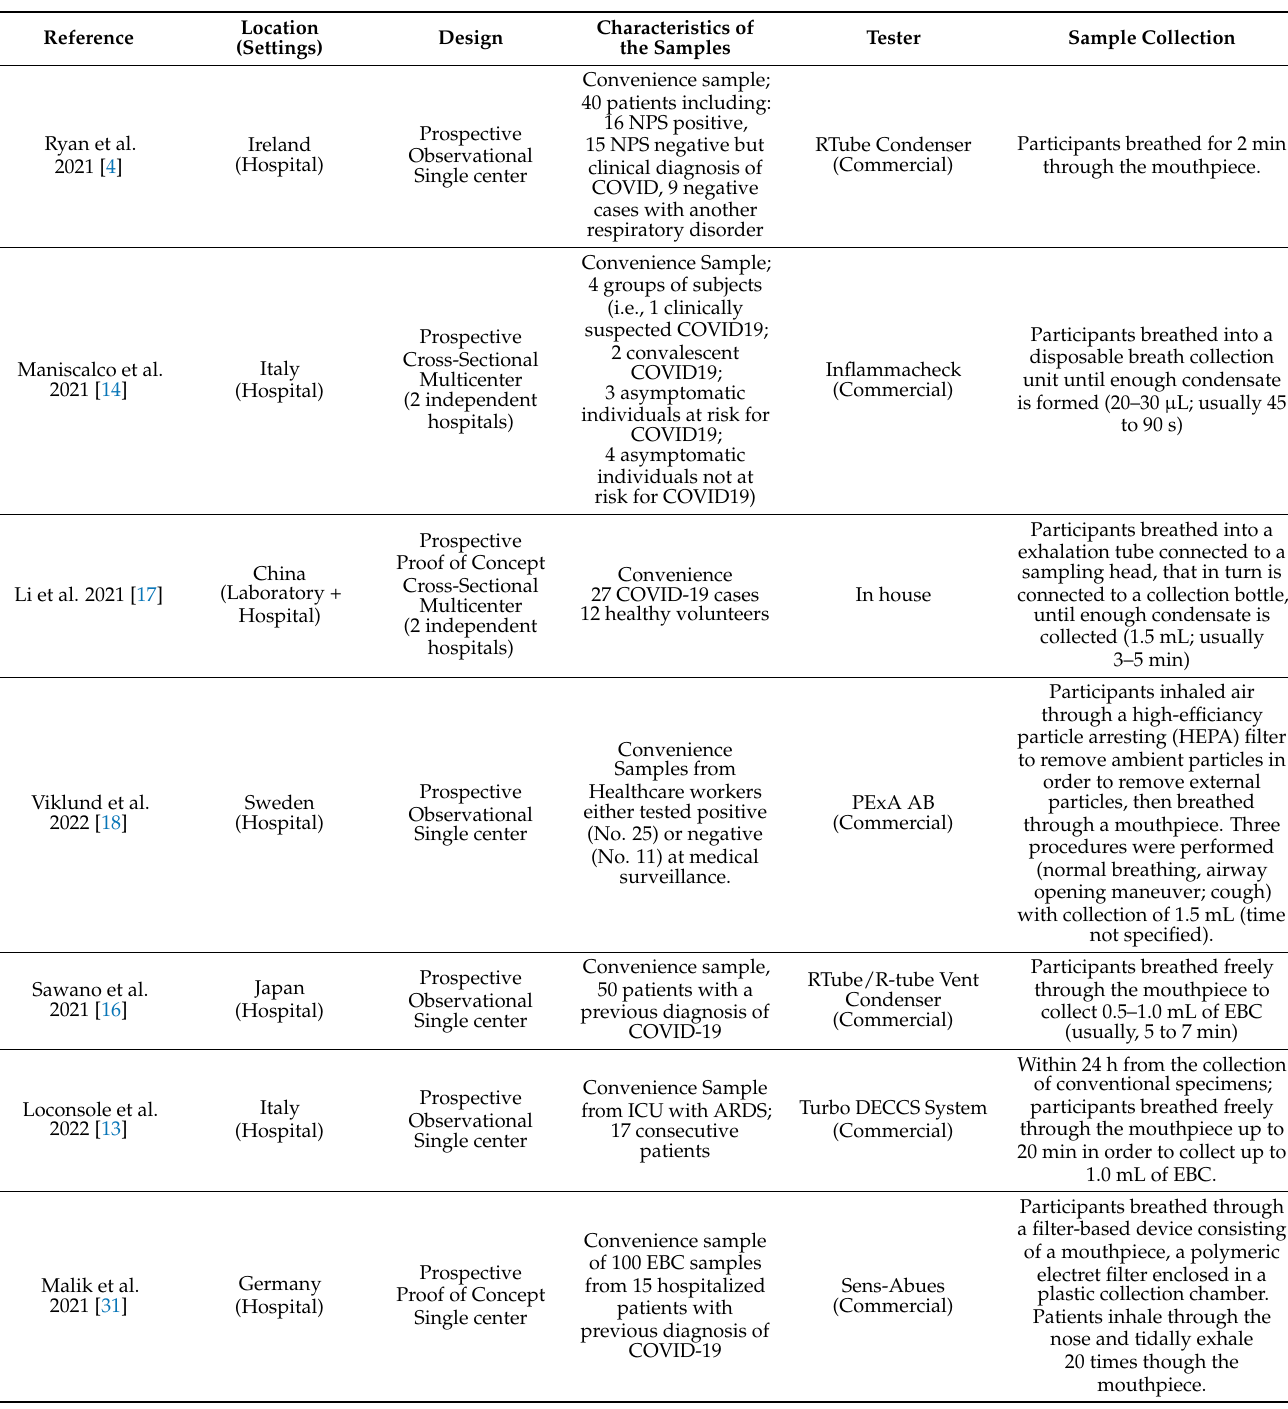
Table 2. A summary of the studies included in the present meta-analysis (Note: EBC = exhaled